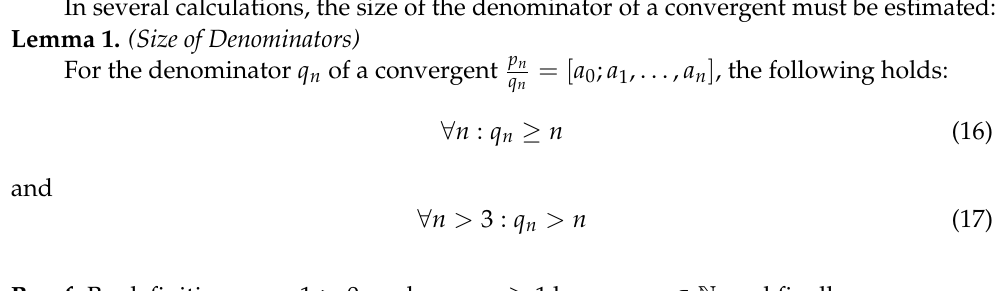
Figure 6. The distance between any two convergents is smaller than the distance between the convergent with the smaller index and its immediate predecessor.